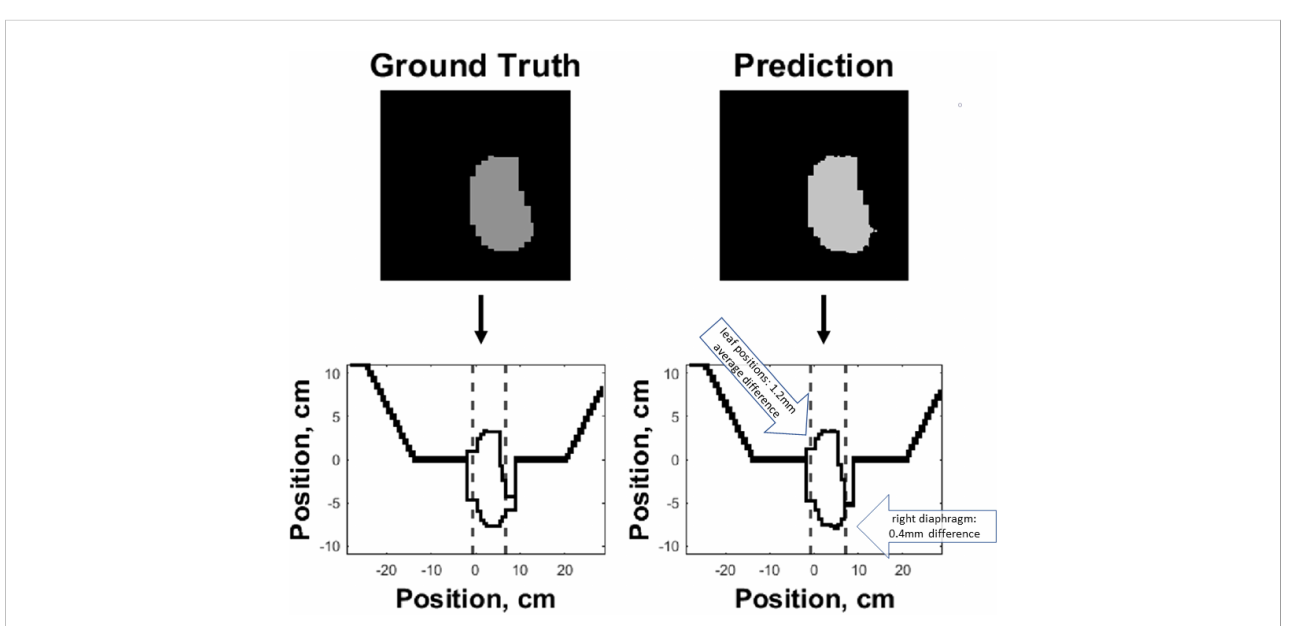
FIGURE 7 Side-by-side comparison of ground truth (left) and predicted (right) fi eld segment shapes (top) and corresponding MLC control banks (bottom) of an example test case. The boundaries of the predicted and ground truth fi eld segment shapes were used to de fi ne the corresponding MLC control points. The dashed lines along the horizontal axis of the two bottom plots represent the jaw positions, while the MLC leaf positions are represented along the vertical axis.